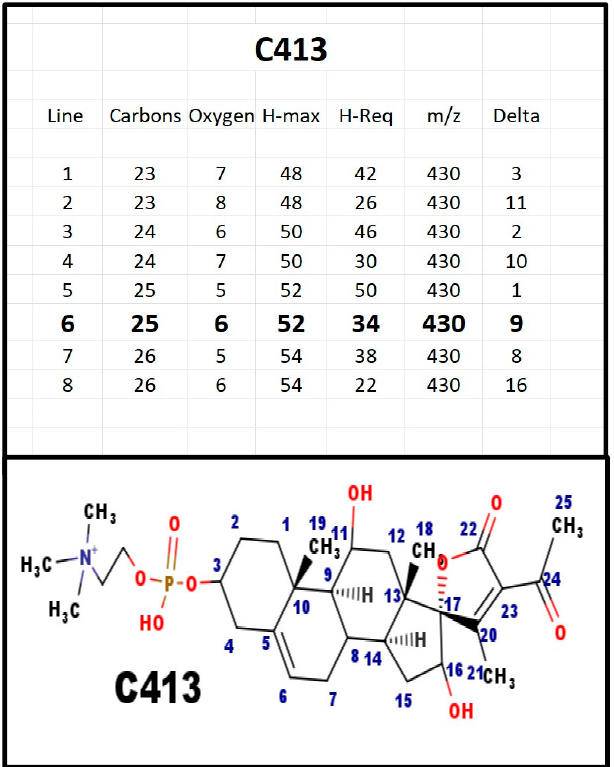
Figure A11. The proposed structures of C413.